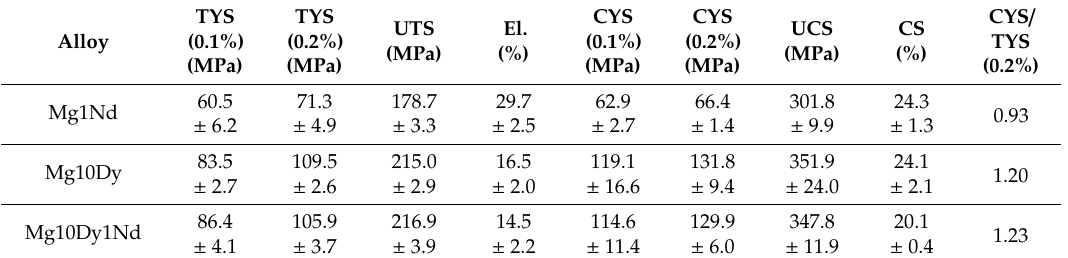
Figure 3. Stress–strain curves for the Mg10Dy1Nd, Mg10Dy and Mg1Nd alloys under tension ( a ) and compression ( b ). Table 2. Tensile and compressive properties and yield strength asymmetry of the extruded alloys.